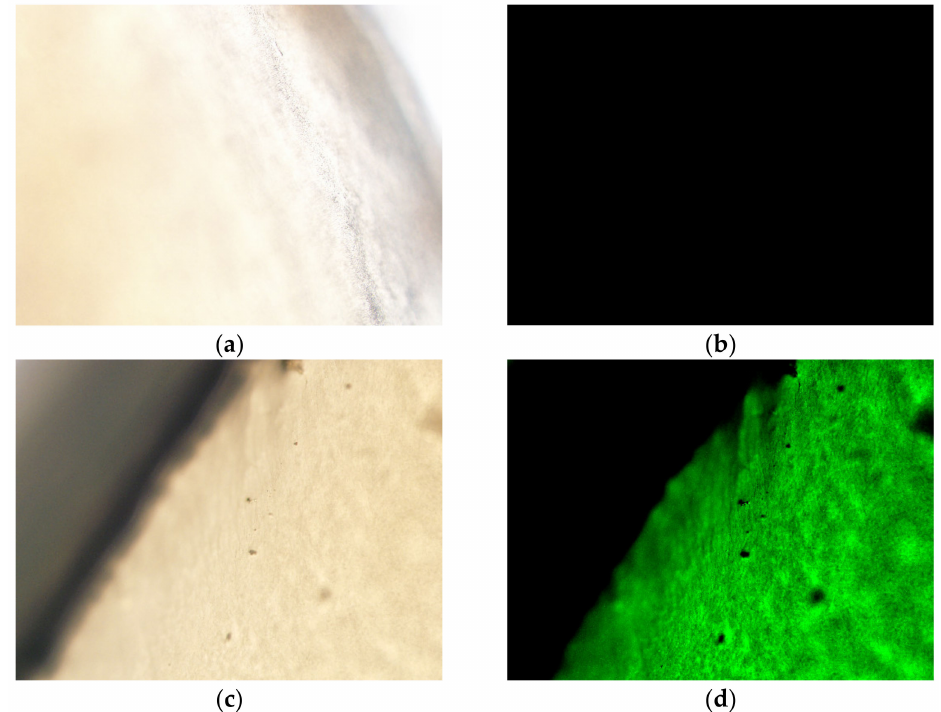
Figure 3. Ex vivo surface distribution analysis using porcine cornea after incubation for 4 h at 37 ◦ C 20 × magnification: All samples are planar images of the excised cornea ( a ) Untreated control cornea (DIC mode), ( b ) untreated control cornea (FITC mode), ( c ) coumarin-6 labelled PSF treated cornea (DIC mode), ( d ) coumarin-6 labelled PSF treated cornea (FITC mode). All treated corneas used 50 µ L of either a 0.1% ( w/v ) coumarin-6 solution or the same volume of an NLC solution loaded with 0.1% ( w/v )